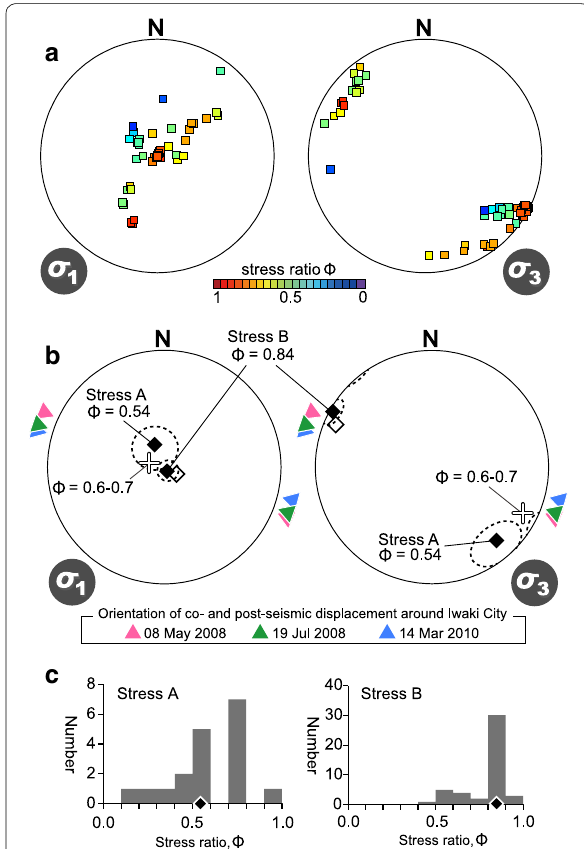
Fig. 2 Crustal stresses around Iwaki City prior to the 2011 Tohoku earthquake. a Lower-hemisphere, equal-area stereographic projec- tions showing the results of the multiple inverse method (MIM; Otsubo et al. 2008) applied to selected events in Fig. 1 (solid circles). The multiple inverse method was applied with the combination 5 and the enhance factor e 8 (see Yamaji (2000) for number k f = = explanations of these parameters). The left and right stereograms show the results for the σ 1 and σ 3 axes, respectively. The colors of the symbols correspond to stress ratios. b Results of k -means clustering (after Otsubo et al. 2006) applied to the data in a . Black diamonds indicate the axes of the optimal stresses. White diamonds indicate the axes of the stress detected from the focal mechanism data earthquakes that occurred between March 12, 2011, and April 11, 2011 (Otsubo et al. 2013). Crosses ( ) indicate the axes of the + normal faulting stress around Iwaki City, as calculated by Imanishi et al. (2012) using the method of Michael (1984). Dashed circles show 95% confidence intervals. Triangles outside stereograms indicate the orientations of co- and post-seismic displacements of the M7 class earthquakes around Iwaki City (Suito et al. 2011). c Histogram of stress ratios of stress tensors calculated by the MIM technique. Diamond symbols indicate calculated mean stress